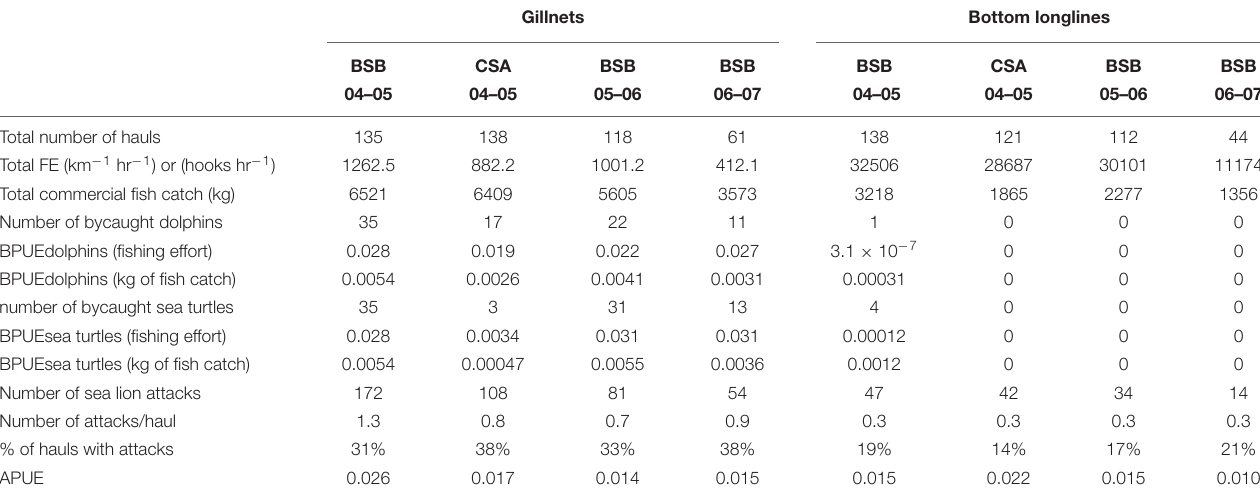
TABLE 5 | Summary of interactions with franciscana dolphins, sea turtles, sea lions in relation to gear type, number of hauls, catch, and fishing effort. Gillnets Bottom